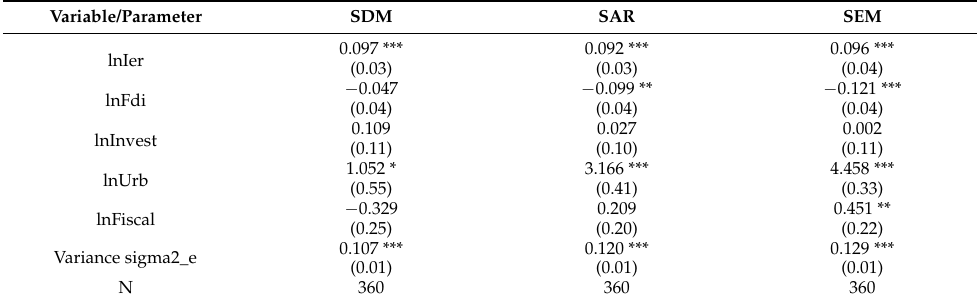
Table 4. Results of spatial econometric model